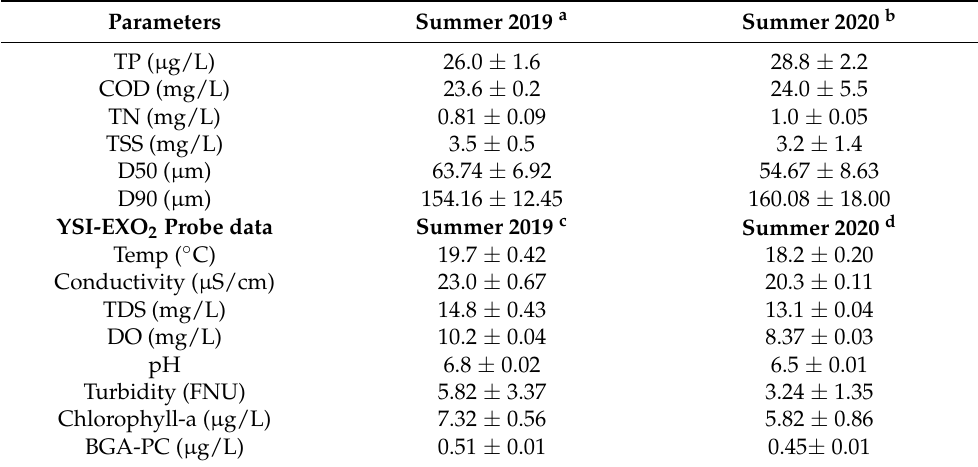
Table 2. Lake Caron water quality during the two summers